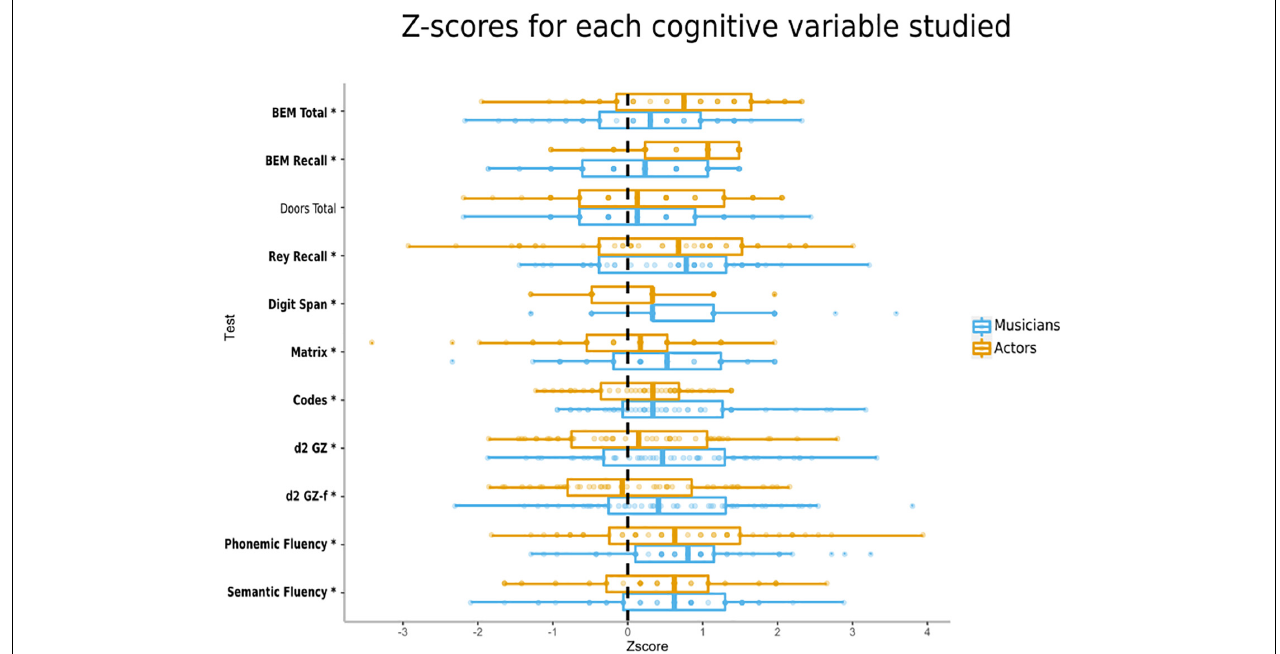
FIGURE 1 | Median, 1st and 3rd quartiles, min and max z -scores for each cognitive variable studied. Mean and standard deviation of the control group ( n = 49) serves as reference population for each measure, as such variables were on the same scale with 0 as the mean and 1 as the standard deviation of the control group. The higher the z -score, the better the performance. ( ∗ ) After a test name indicates a significative difference between Controls and Musicians or